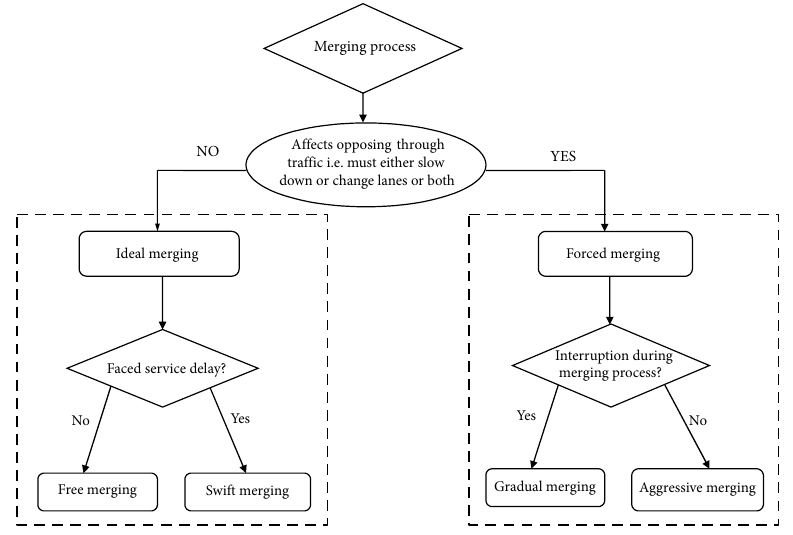
Fig. 2. Different types of